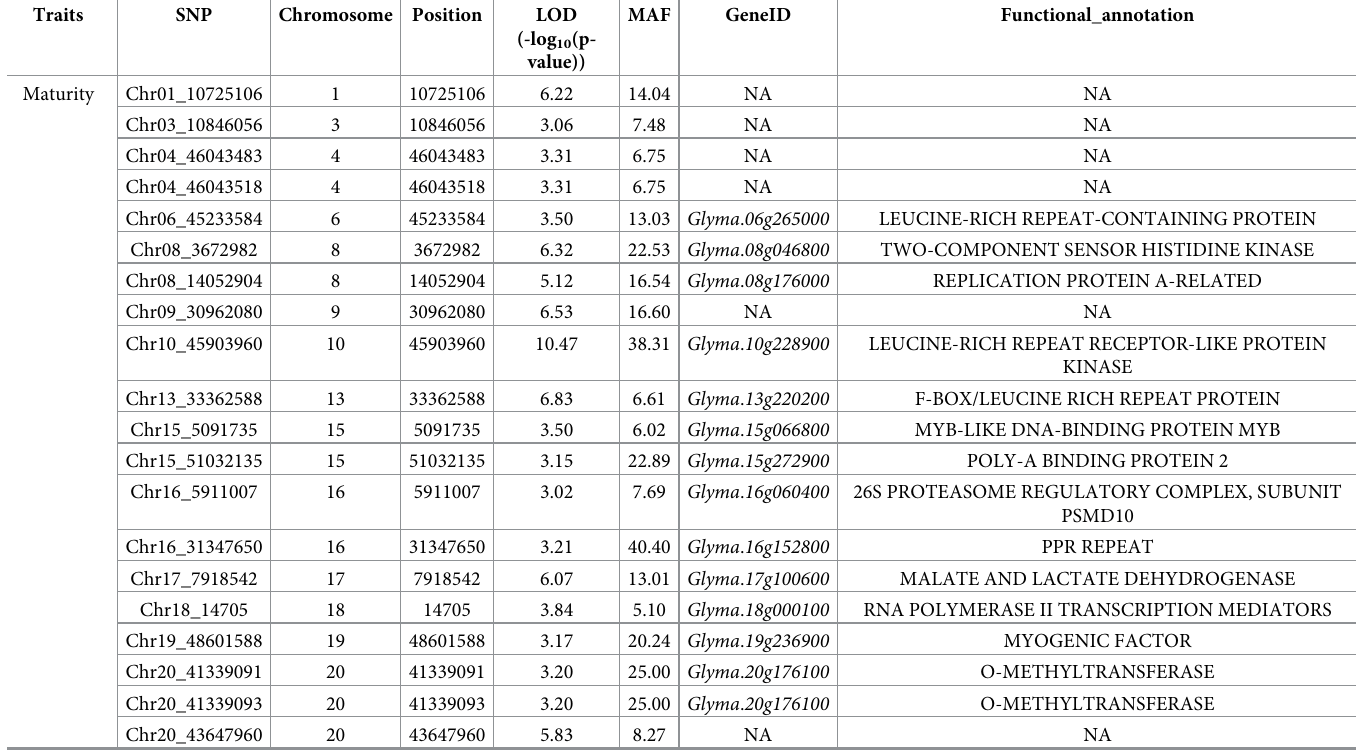
pared to the whole panel, prediction accuracy for maturity was reduced in Q1 panel but increased in Q2 panel (Fig 2). On average, the prediction accuracy was the highest for seed weight (0.84) and was the lowest for maturity (0.47) (S7 Table). Interestingly, prediction accu- racy averaged 0.64 with a less variation between traits and across years when samples from Q2 were used to estimate prediction accuracy of seed weight (Fig 2). In addition, accuracy for pre- dicting maturity was the best using Q2 samples (Fig 2) (S7 Table). The ANOVA results indi- cated a statistically significant interaction effect between the year and population type on the prediction accuracy of GS for maturity, plant height, seed weight, and yield (S8 Table). The results indicated that year and population structure were important factors to take into account when evaluating the prediction accuracy in the GS approach. Table 1. Significant SNPs associated with the average maturity and plant height over 3 years, chromosome and physical position of the significant SNPs, LOD (-log10(p-value)) values, minor allele frequency at the SNP locus, and gene ID and functional annotation. Traits SNP Chromosome Position LOD MAF (-log 10 (p- value))